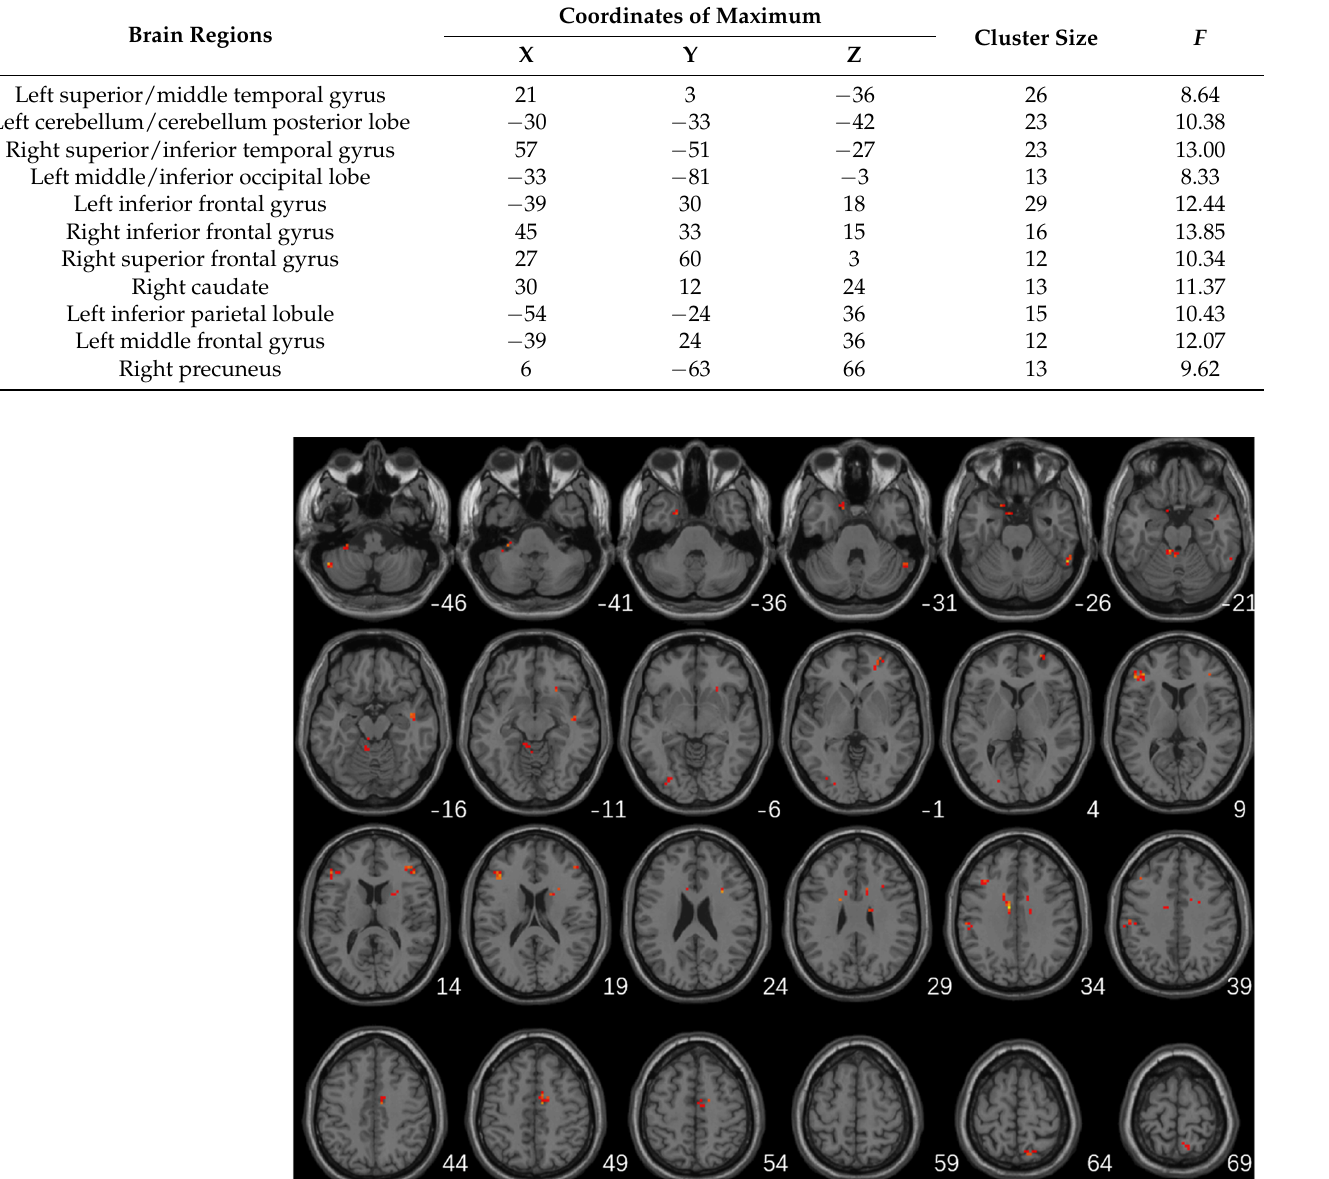
Table 2. Brain regions with significant differences in fALFF among the three groups.